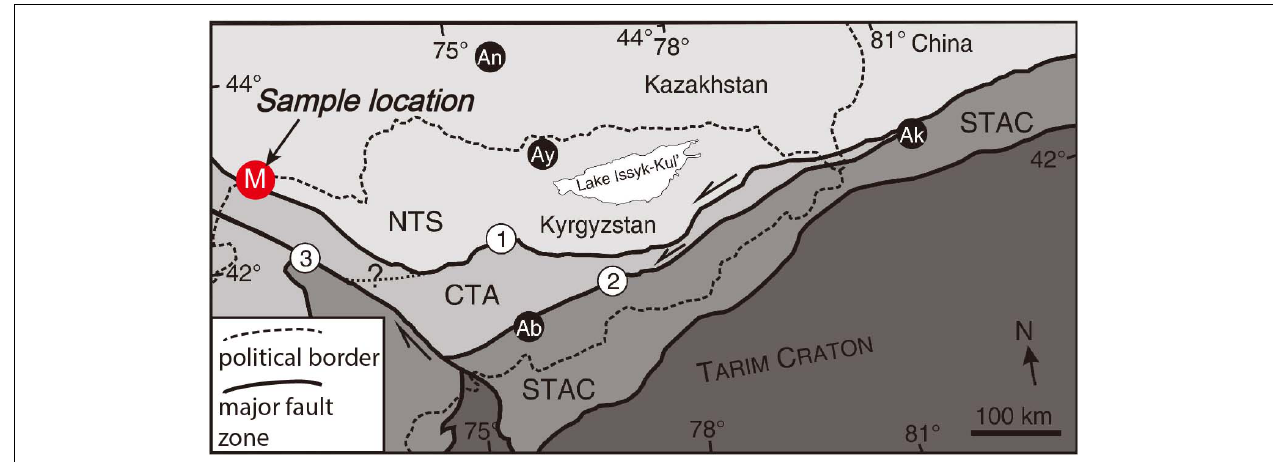
FIGURE 1 | Tectonic sketch map showing the sample location. Major tectonic units are shown (NTS: Northern Tianshan; CTA: Central Tianshan Arc Terrane; STAC: Southern Tianshan Accretionary Complex). Ultra high-pressure metamorphic complexes in the Tianshan orogen are labeled as follows: Makbal (M), Aktyuz (Ay), Atbashi (Ab), and Anrakhai (An) (modified after Meyer et al., 2014).